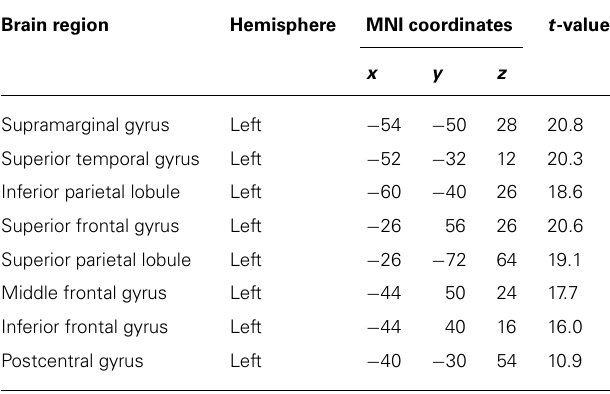
Table 2 | Brain regions showing significant IC with the left M1 during imagined movements.